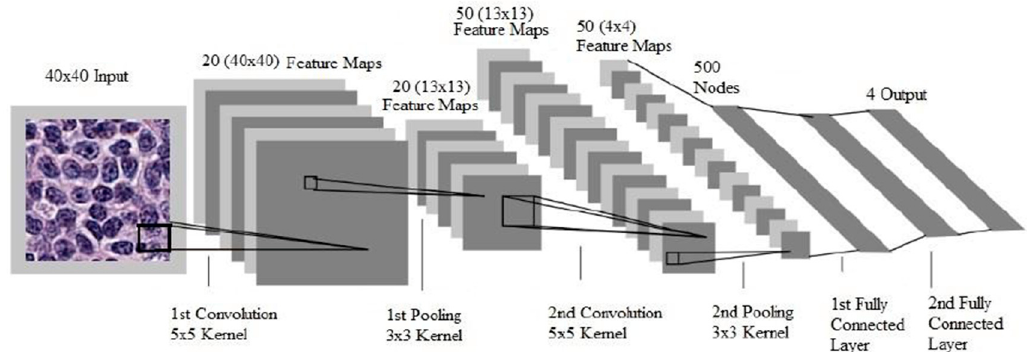
Figure 2. Processing pipeline of a convolutional neural network for the detection of visual categories in images. Example of a CNN model proposed previously by other authors. The convolutional layers perform feature extraction consecutively from the image patch to higher-level features. The pooling layers reduce image size by subsampling. The last fully connected layers provide prediction based on the given features. Reproduced with permission from Hanadi El Achi [32].